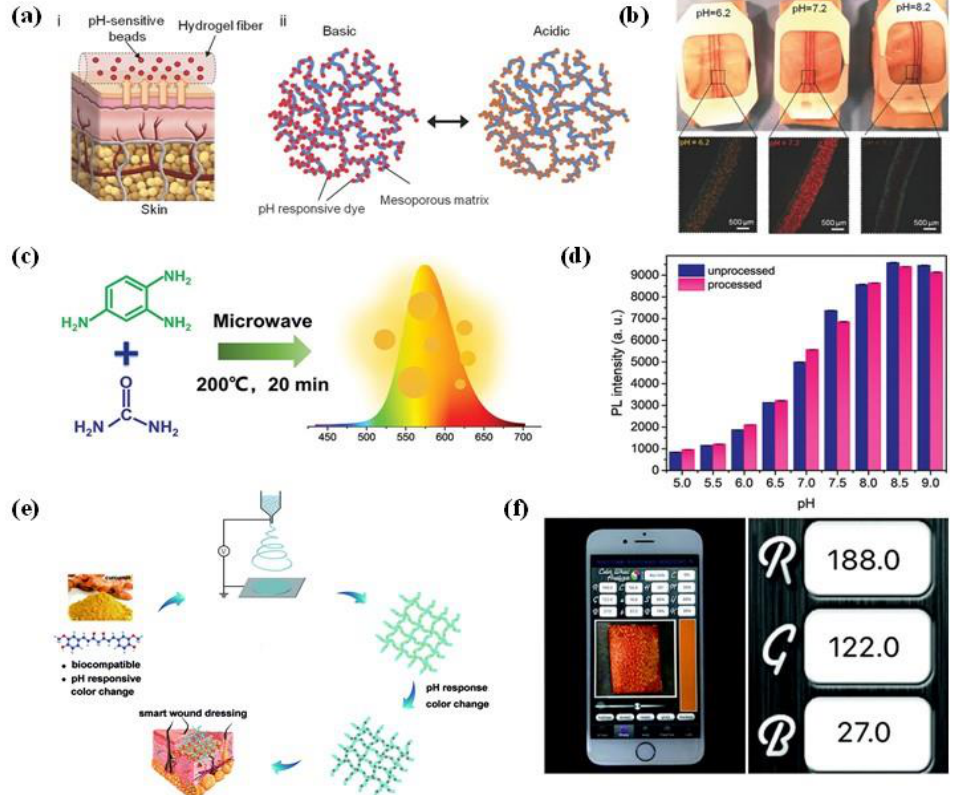
Figure 3. ( a ) Schematic illustration of alginate-based hydrogel microfibers loaded with pH-respon- sive beads (i) and the action mechanism of solid matrix of the mesoporous particles (ii); ( b ) the wound dressings fabricated by hydrogel microfibers response to different pH (Reprinted with permission from [51]); ( c ) synthesis of orange-emissive carbon quantum dots (O-CDs); ( d ) compar- ison of photoluminescence intensities of O-CDs on medical cotton cloth (MCC) before and after immersion in phosphate-buffered saline (PBS) buffers with different pH (Reprinted with permission from [52]); ( e ) fabrication process of curcumin-loaded fibers used for wound pH detection; ( f ) RGB (red, green, blue) values of polymer fibers after pH detection were determined by smartphone (Reprinted with permission from [36]).